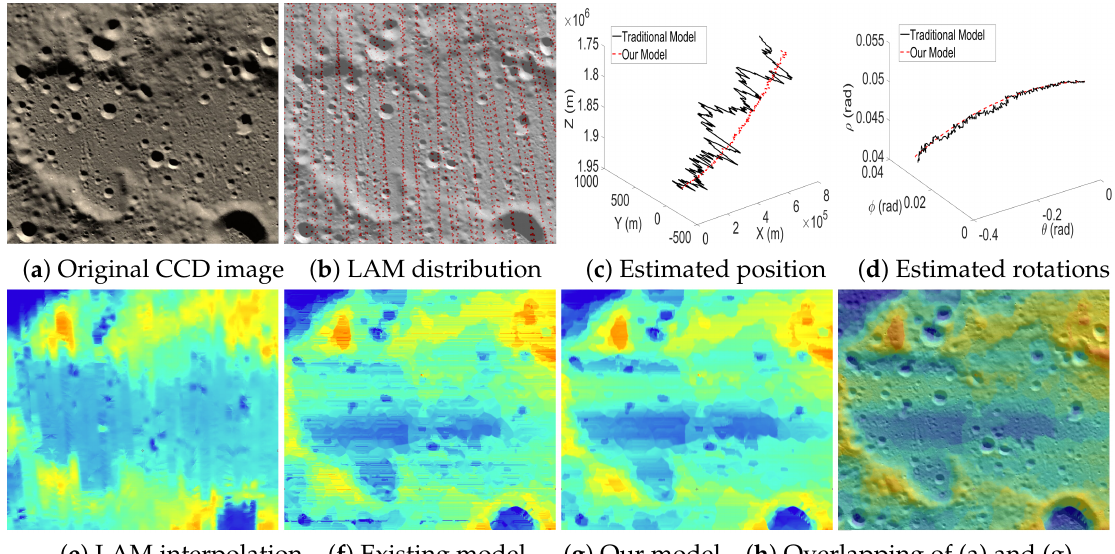
Figure 11. Case 1 with dense LAM distribution. ( c , d ) The curves of the spatial position and angular rotations estimated by the existing model (black) and our model (red); ( f , g ) the reconstructed altitude maps for ( a ) based on the estimated EOPs by the existing model and our model, respectively.